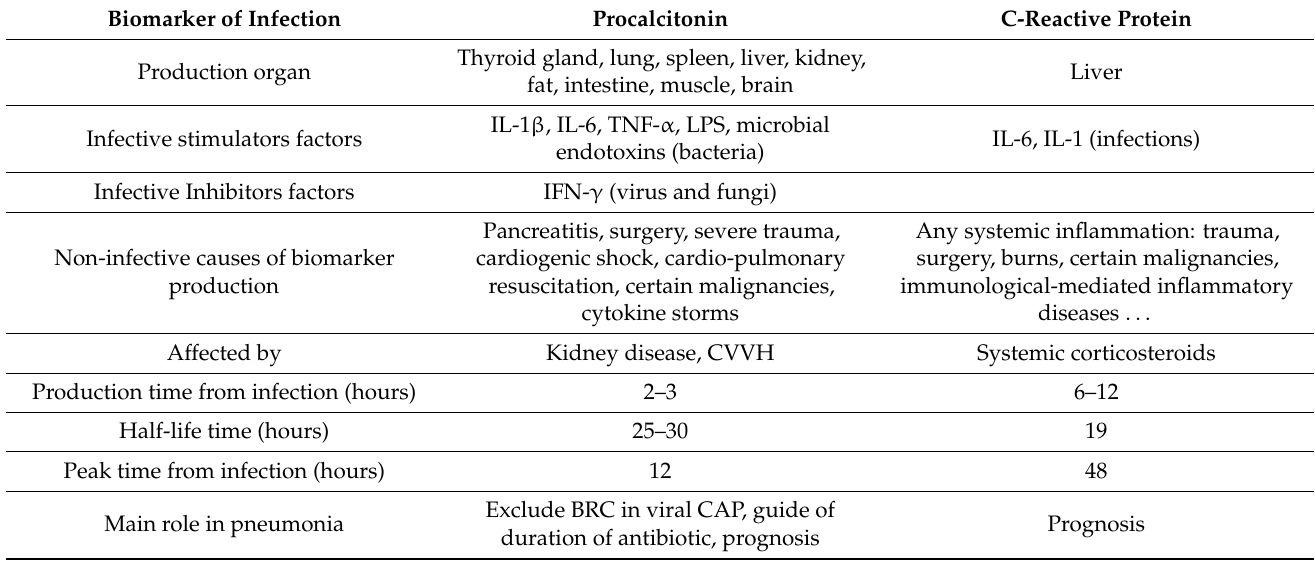
Table 1. Main characteristics of PCT and CRP production, kinetics and its main role in pneumonia. Procalcitonin C-Reactive